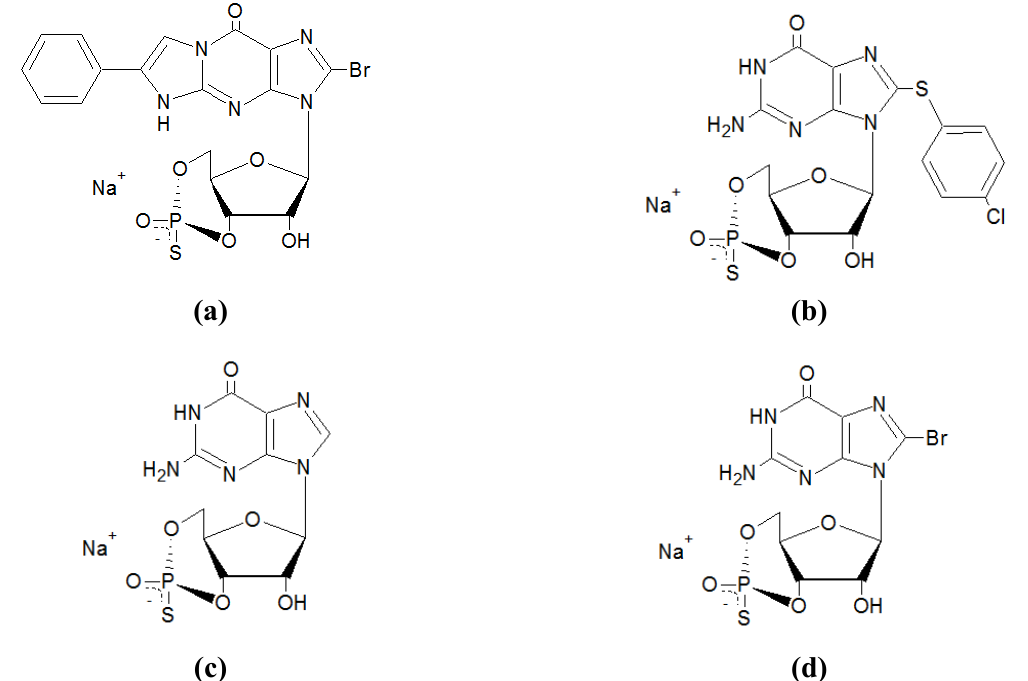
) for the cGMP-dependent protein kinases. The inhibition i